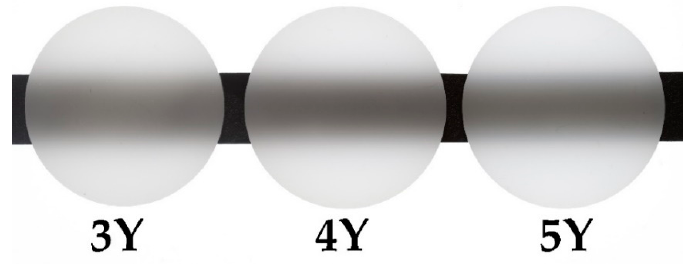
( f ) Figure 5. SEM micrographs of as-sintered zirconia surface at magnification ×25,000 (left) and mag- nification ×60,000 (right): 3Y specimen ( a , b ), 4Y specimen ( c , d ), and 5Y specimen ( e , f ). The translucency parameter (TP) significantly differed between different types of zir- conia ceramics (ANOVA, Tukey P < 0.05); the lowest TP was observed in the 3Y-APA